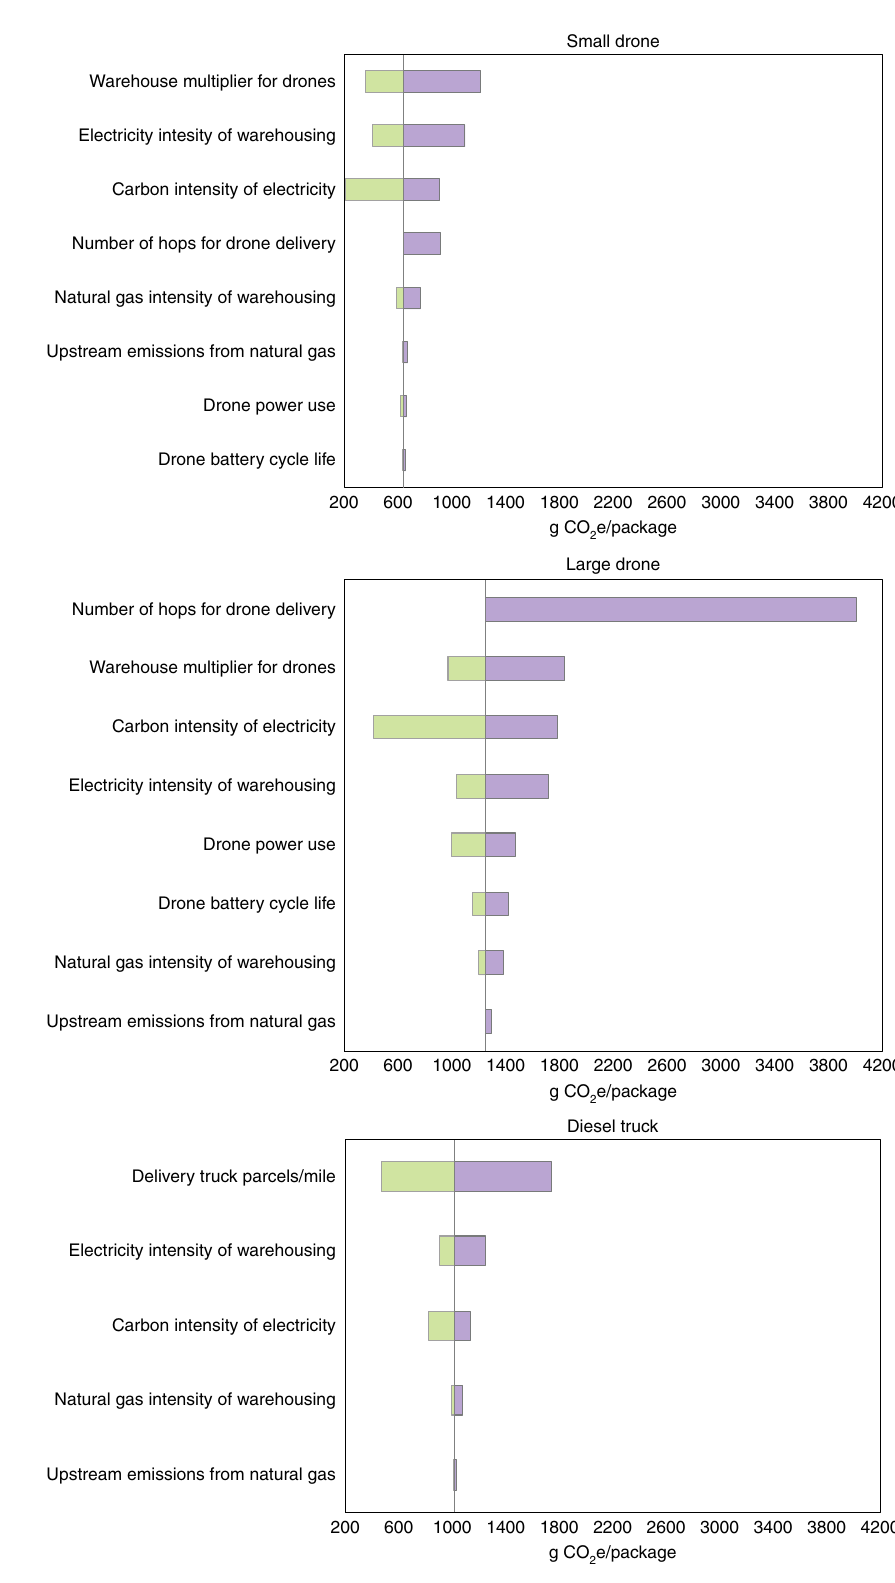
Fig. 6 Sensitivity analysis. Greenhouse gas emissions per package delivered for the quadcopter, octocopter, and diesel truck under the parameters listed in Table 2. Vertical lines mark the base case result for each mode. Green bars show the decrease in emissions and purple bars show the increase in emissions given parameters Table